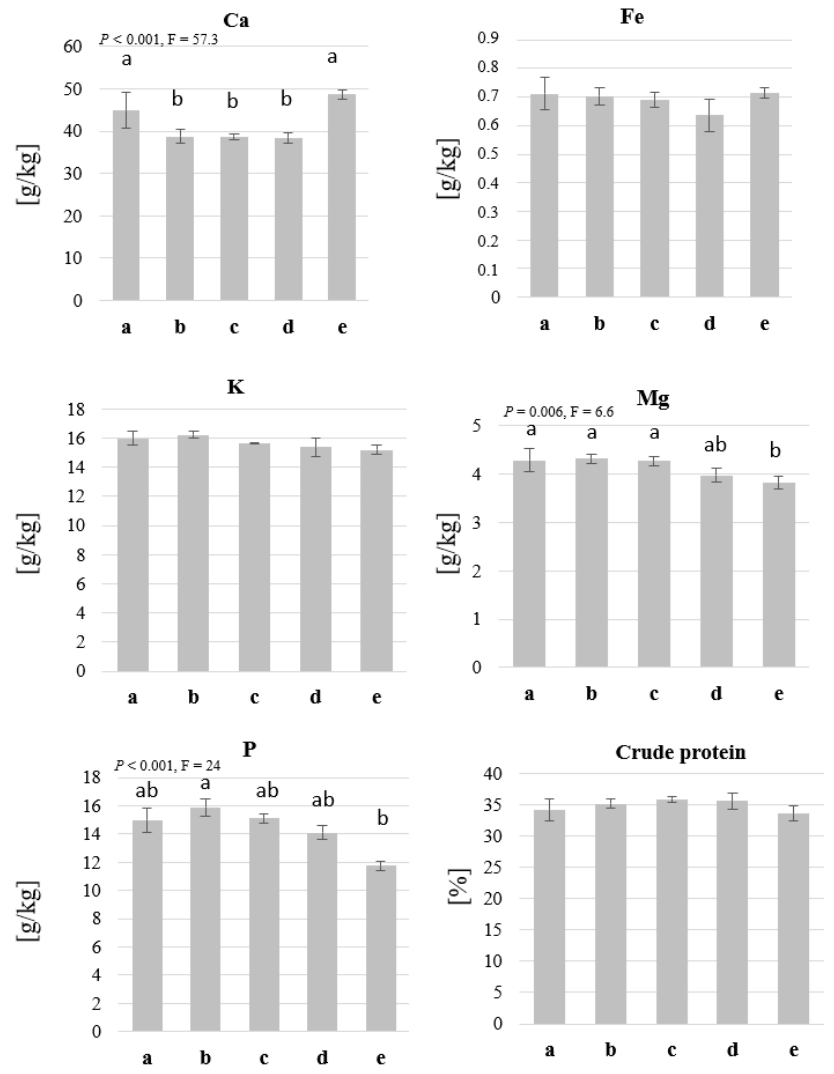
Figure 6. Protein and micronutrients in BSFL grown on substrates with different straw particle sizes. BSFL were grown on substrates that contain > 3 mm straw (a), 2–3 mm straw (b), 1.25–2 mm straw (c), 1–1.25 mm straw (d), or ≤ 1 mm straw (e). The larvae were harvested and analysed for crude protein, Ca, Fe, K, Mg, and P concentrations. ANOVA (n = 5, p < 0.05) followed by a Bonferroni post hoc test revealed significant differences between the treatments in Ca, Mg, and P concentrations, and no differences in the case of Fe, K, and crude protein. The means and standard deviations are shown in the graph, and the letters above the columns indicate the different groups.